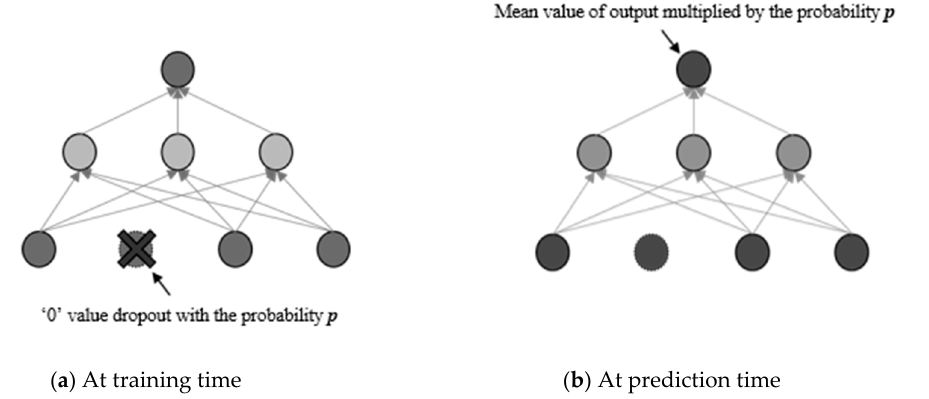
Figure 4. ( a ) The unit training time step that is present with a probability of p ; ( b ) the use of output with a probability of p during the prediction time step.